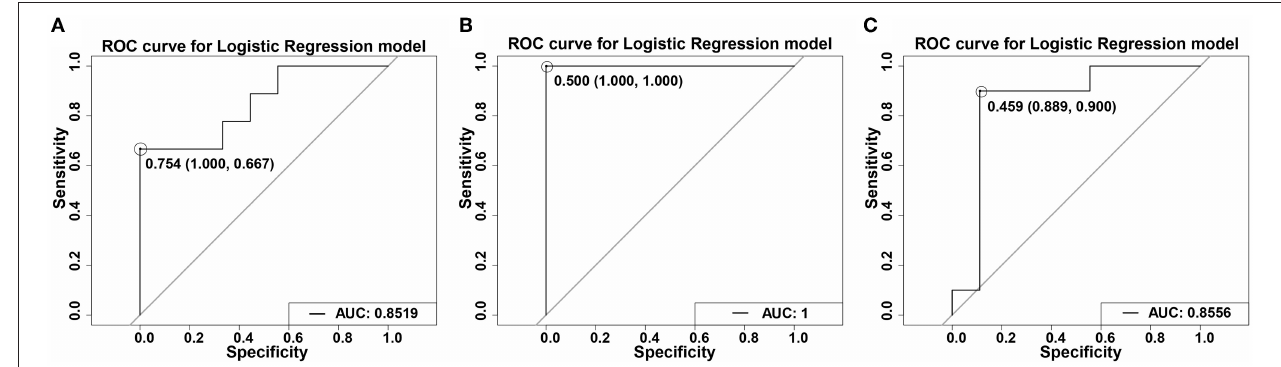
FIGURE 9 | ROC curves of the TGs using a logistic regression model. (A) ROC curve of R1 vs. C1 of the TGs using a logistic regression model at stage 1. AUC = 0.8519. (B) ROC curve of F1 vs. C1 of the TGs using a logistic regression model at stage 1. AUC = 1. (C) ROC curve of R2 vs. C2 of the TGs using a logistic regression model at stage 1. AUC = 0.8556. TGs including TG (16:0/16:1/18:2) and TG (16:0/16:0/16:1). The figures in the picture refer to the cutoff values. The numbers in the parentheses are the sensitivity and specificity, respectively.